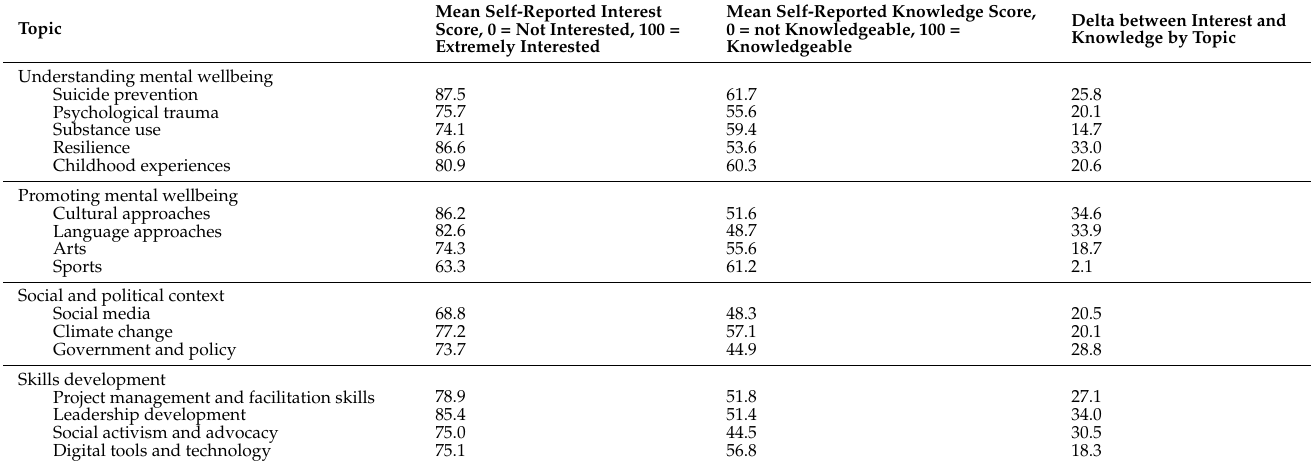
Table 2. Results of participant needs assessment—mean self-reported interest and knowledge scores.